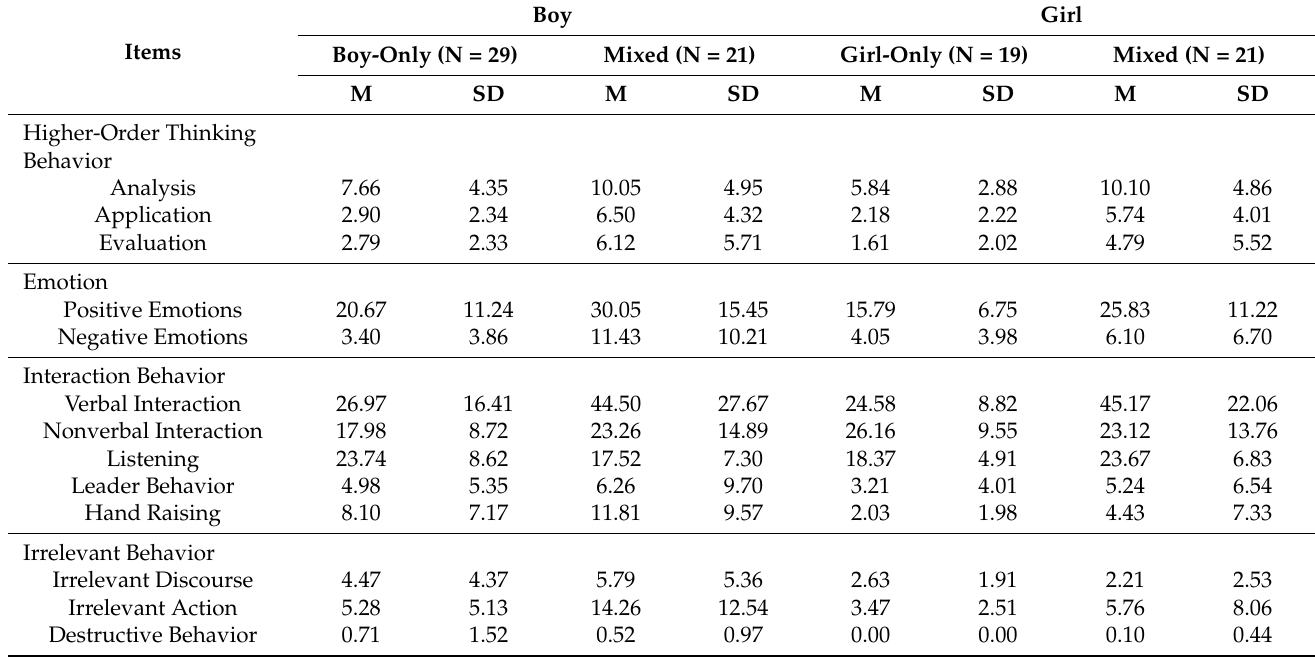
Table A2. Means and standard deviations for boys and girls in different gender